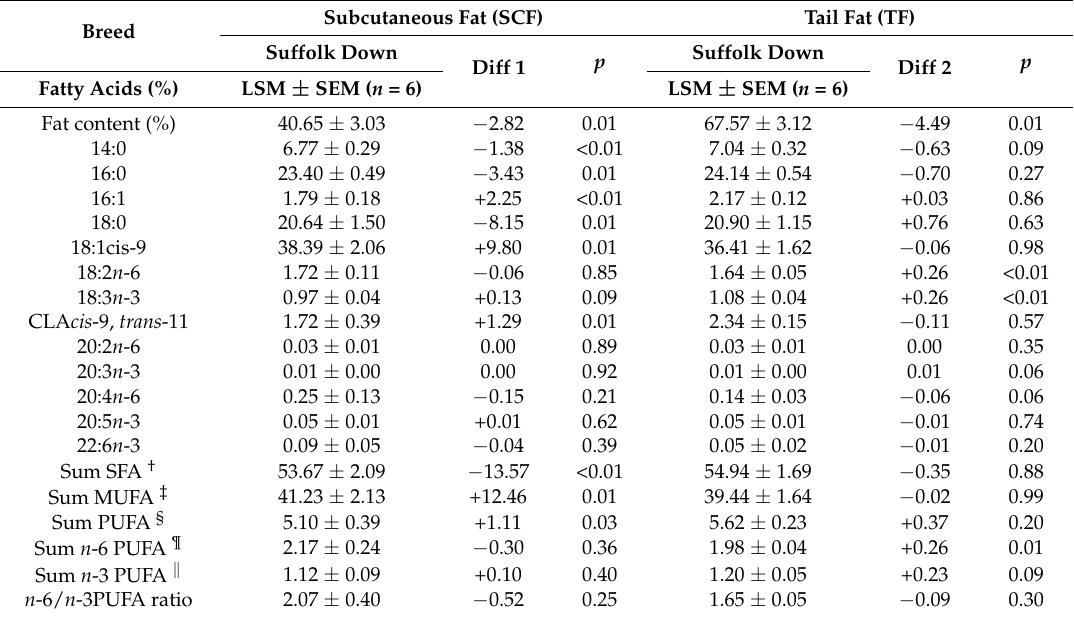
Table 3. Fatty acid composition (%) of subcutaneous (from the back) and tail fats of Suffolk Down lambs compared with the reported data for Chilota lambs grazing Calafatal. Subcutaneous Fat (SCF) Tail Fat (TF) Breed Suffolk Down Suffolk Down Diff 2 p Diff 1 p Fatty Acids (%) LSM ± SEM ( n = 6) LSM ± SEM ( n = 6) Fat content (%) 40.65 ±